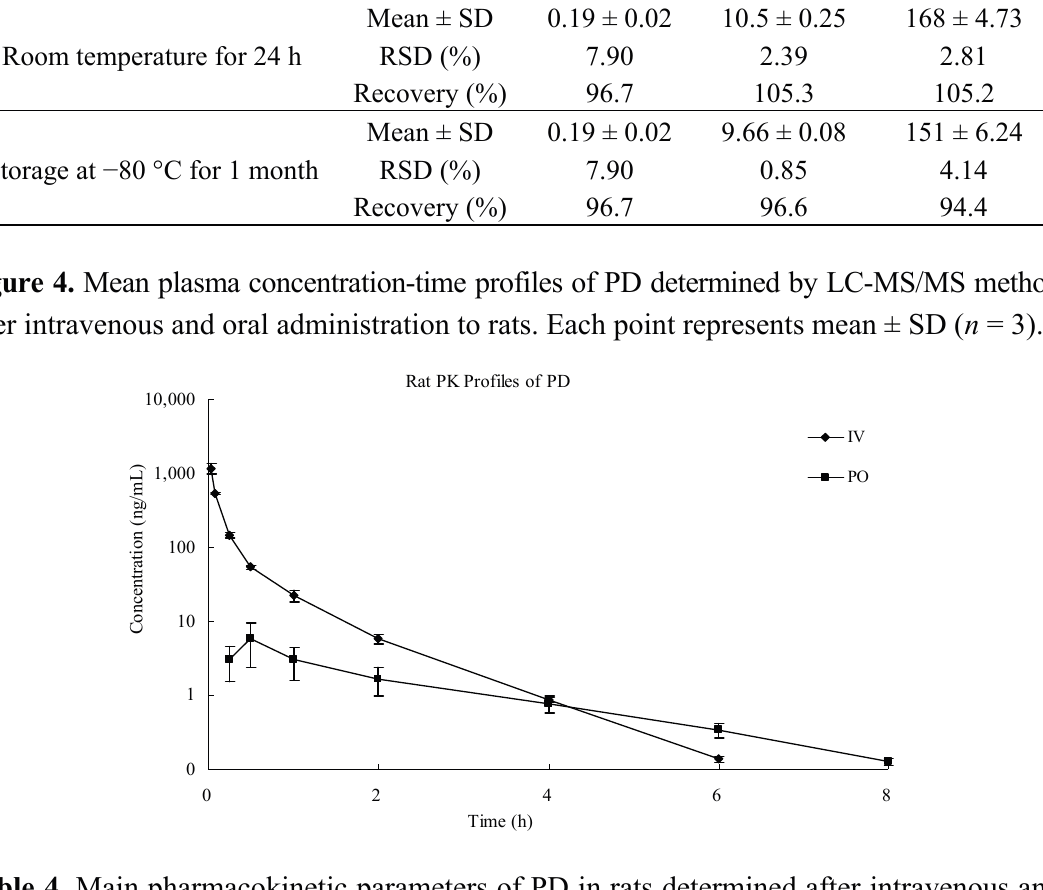
Table 4. Main pharmacokinetic parameters of PD in rats determined after intravenous and oral administration ( n = 3, mean ±